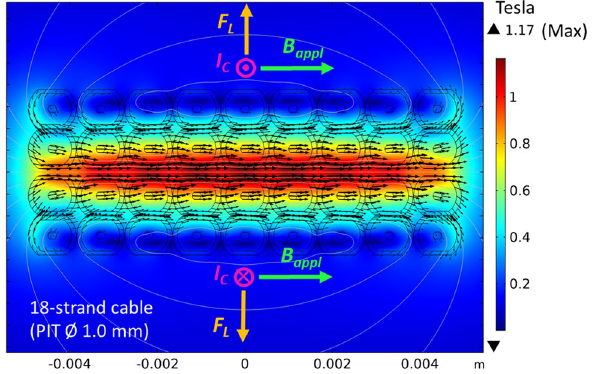
Figure 11. The self-field map calculated by finite elements software (COMSOL Multiphysics) at 10 kA. The peak field lies at the centre of the stack, with a negligible y -component. The white lines represents the contour plot (lines of constant magnitude) of the potential vector, directed along the z -direction. The background field is chosen in such a way to optimize the peak field. The resulting Lorentz forces, F L , acting on the current-carrying sample, are also